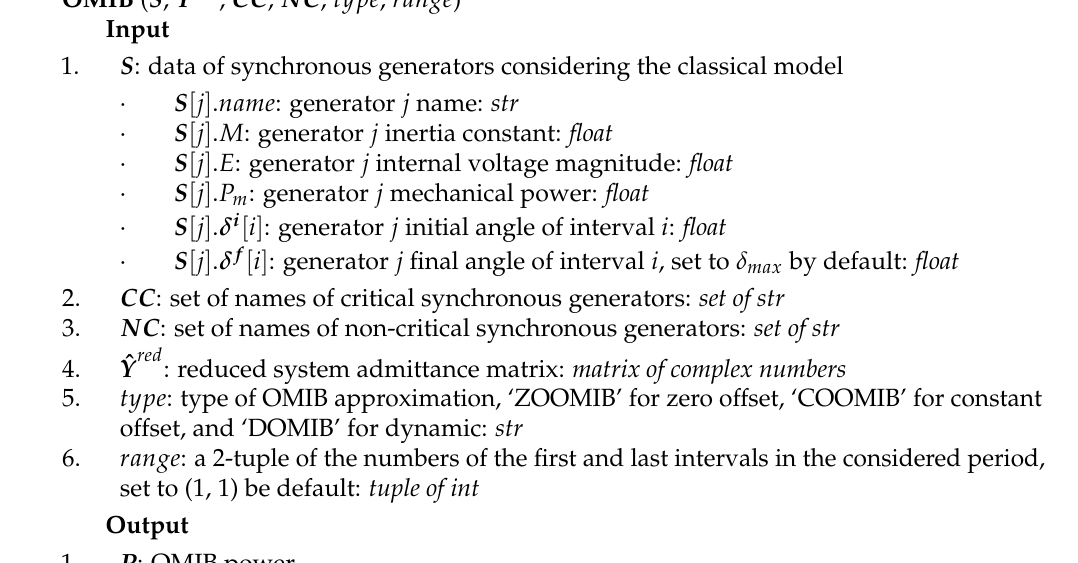
Algorithm A1 Forming the OMIB equivalent of a multi-machine power system red OMIB ( S , ˆ Y , CC , NC , type , range